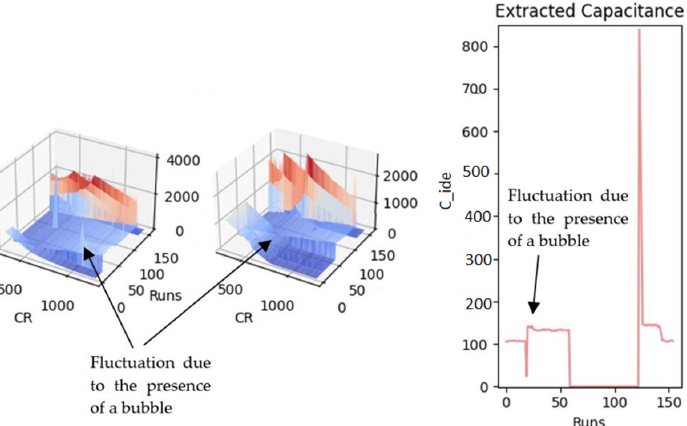
Figure 22. The fluctuated pattern due to the presence of a bubble created during sample placement.